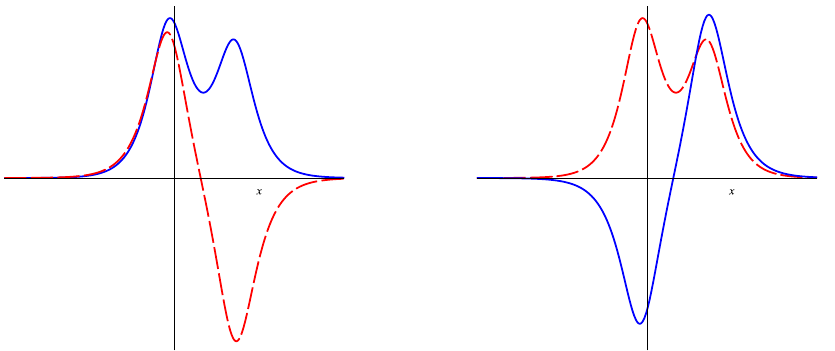
Figure 2. u [ 2 ] (blue solid line) and u [ 2 ] (red dashed line) for t = 0, λ 0 = 1, k 0 = 0.2, and for θ 0 = 0 ( left ) and θ 0 = π ( right 2